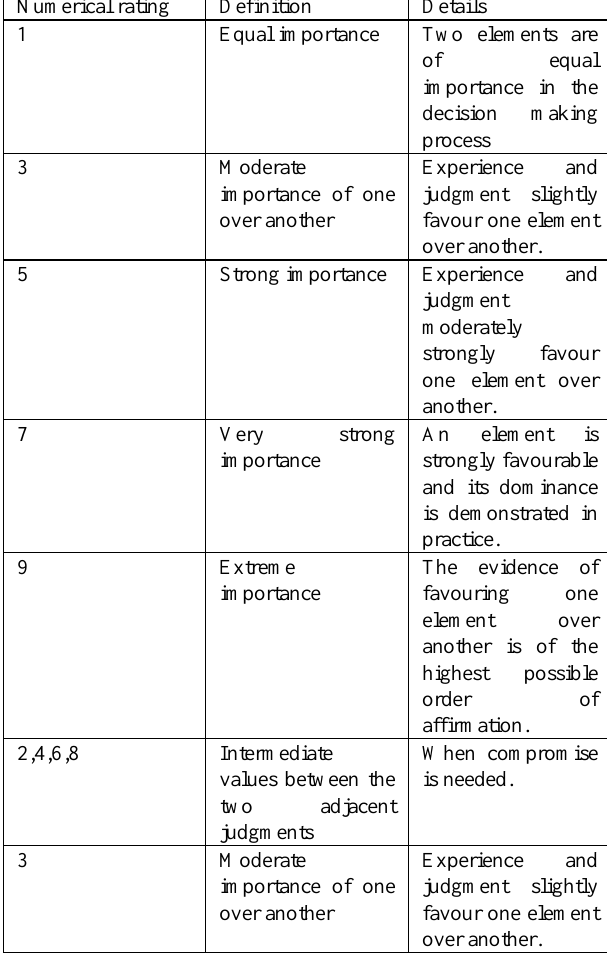
Table 2: Pairwise Comparison Scale of Judgment preferences